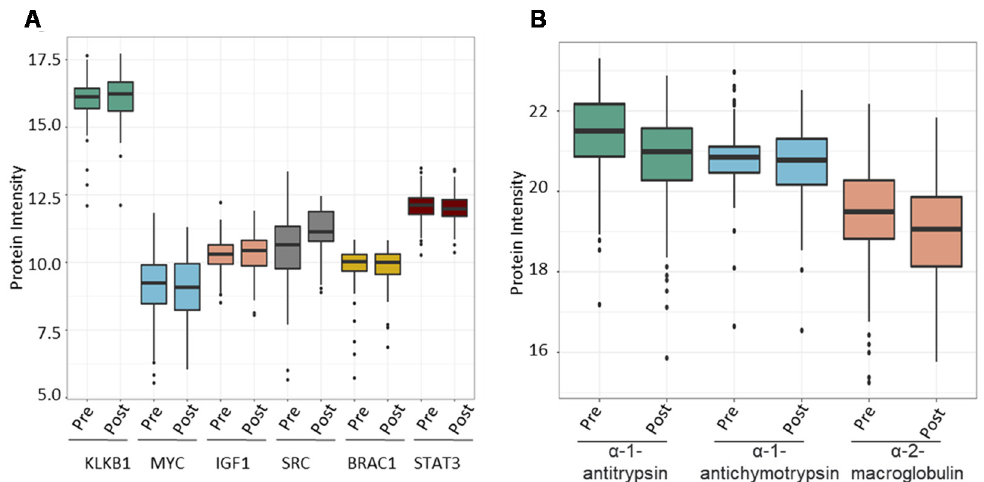
Figure 7. The combined PCa serum library’s utility in finding known prostate cancer-associated proteins. ( A ) Expression of known prostate cancer biomarkers across samples from the validation cohort. ( B ) Expression of proteins that bind to free PSA in human serum.